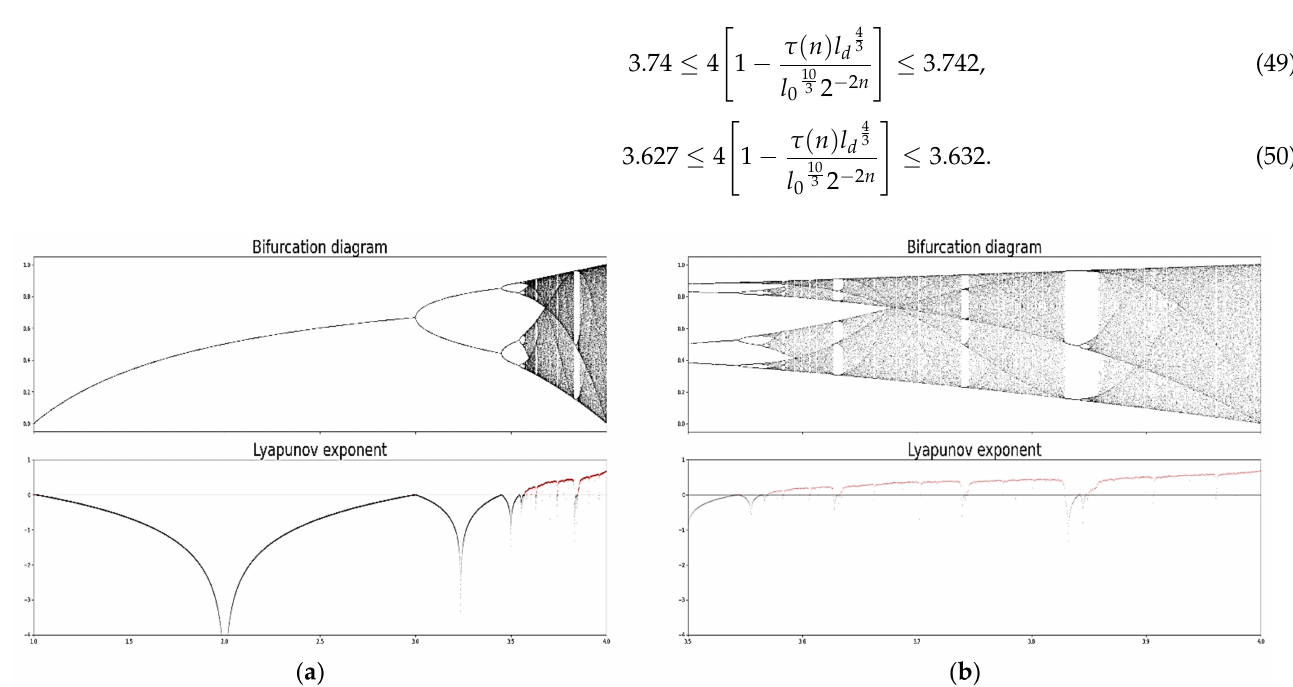
Figure 7. Bifurcation diagram and associated Lyapunov exponent plot of the logistic map: ( a ) normal; ( b ) zoomed-in onto regions of